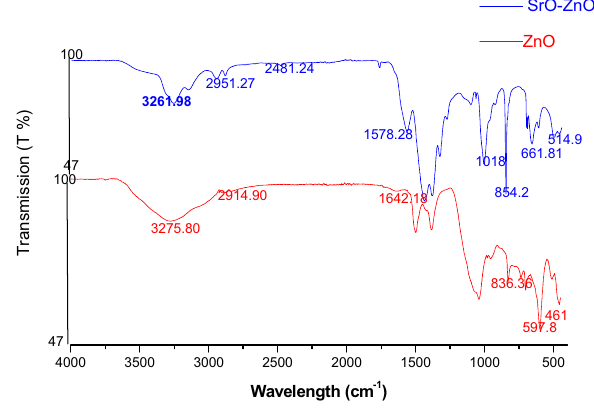
Fig. 2 FTIR spectra of ZnO and SrZnO